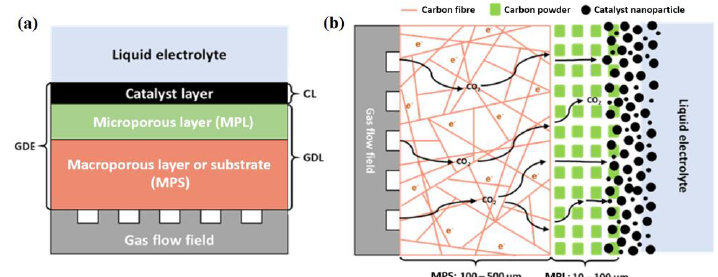
Figure 1. Simplified schematics of a gas di ff usion electrode (GDE). ( a ) Stacked structure of a GDE